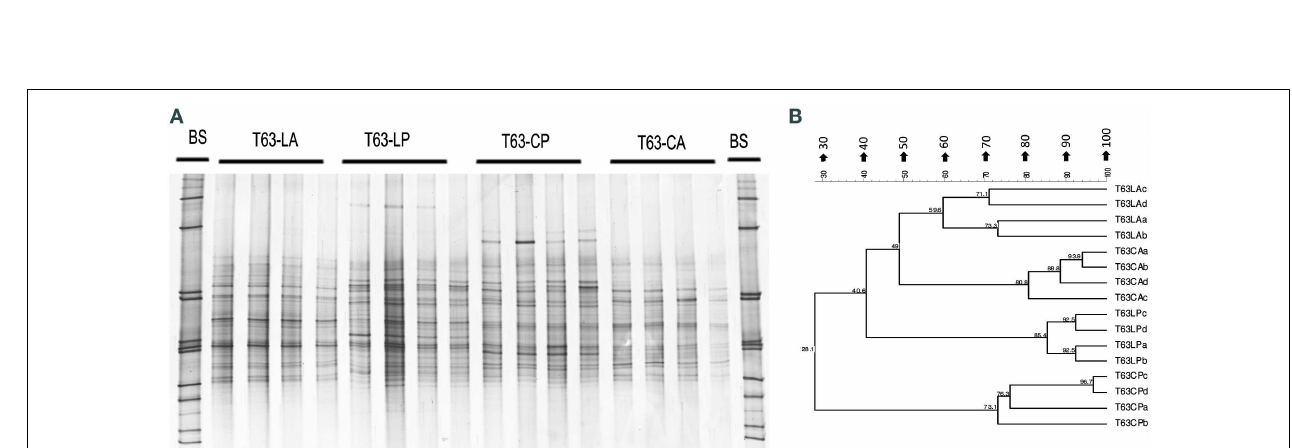
FIGUREA2 | Betaproteobacteria -specific DGGE fingerprint (A), corresponding UPGMA clusters (B) for soils spiked with phenanthrene (LP: phenanthrene-spiked Luvisol, CP: phenanthrene-spiked Cambisol) or not (LA: Luvisol control, CA: